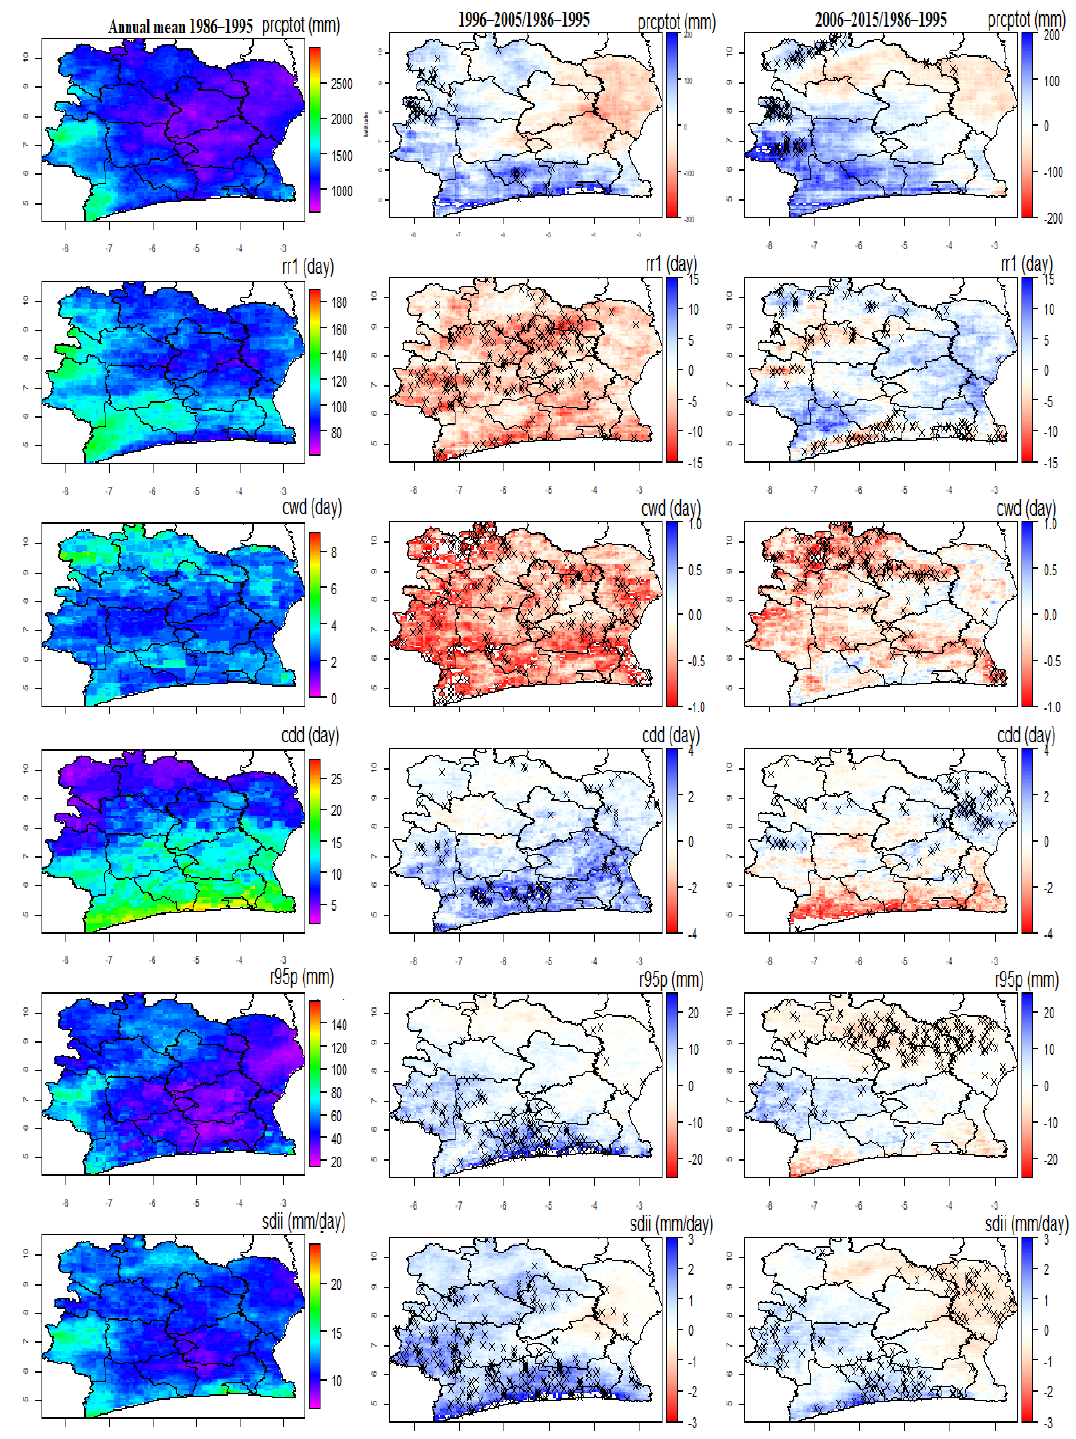
Figure 10. Spatial patterns of precipitation indices over Côte d’Ivoire: mean over the reference decade 1986–1995 (first column); change over the 1996–2005 decade (second column) and changes over the 2006–2015 decade relative to the reference decade (third column). Areas with the symbol (x) are significant at a 95% confidence level.